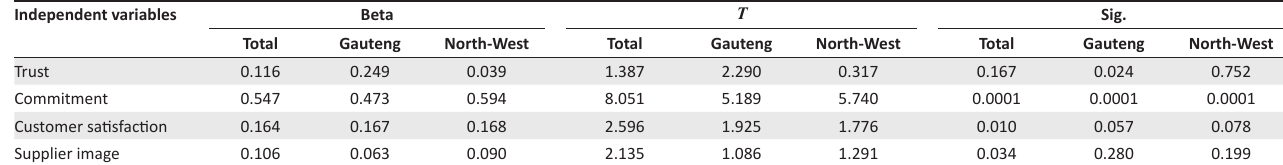
TABLE 4: Regression